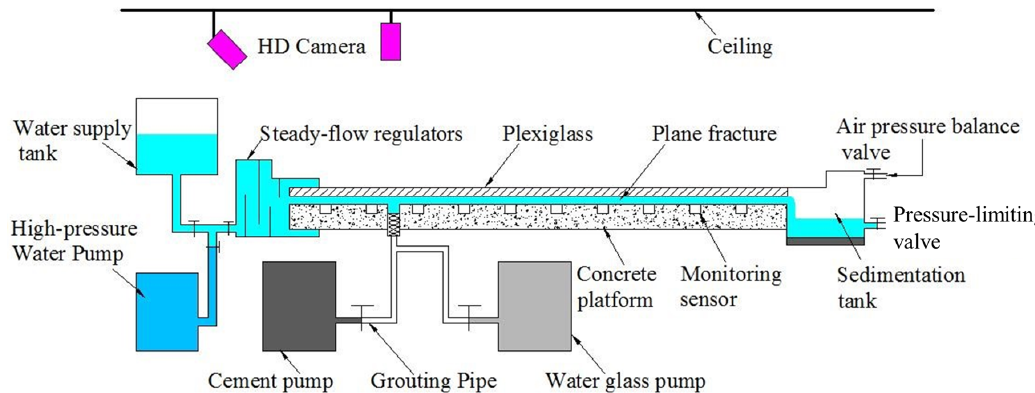
Figure 3. Schematic of the fissure in the grouting model test.